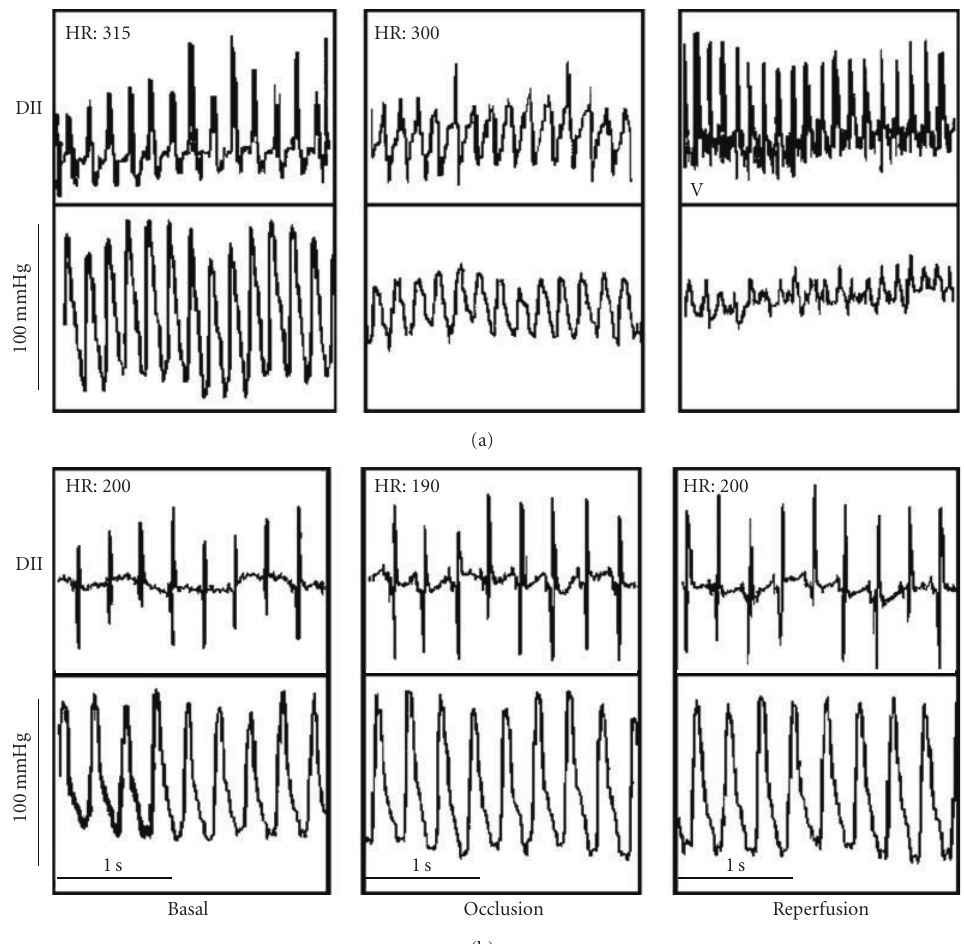
Figure 2: Electrocardiogram of control (a) and hypothyroid (b) rats (modified from [34]). See text for